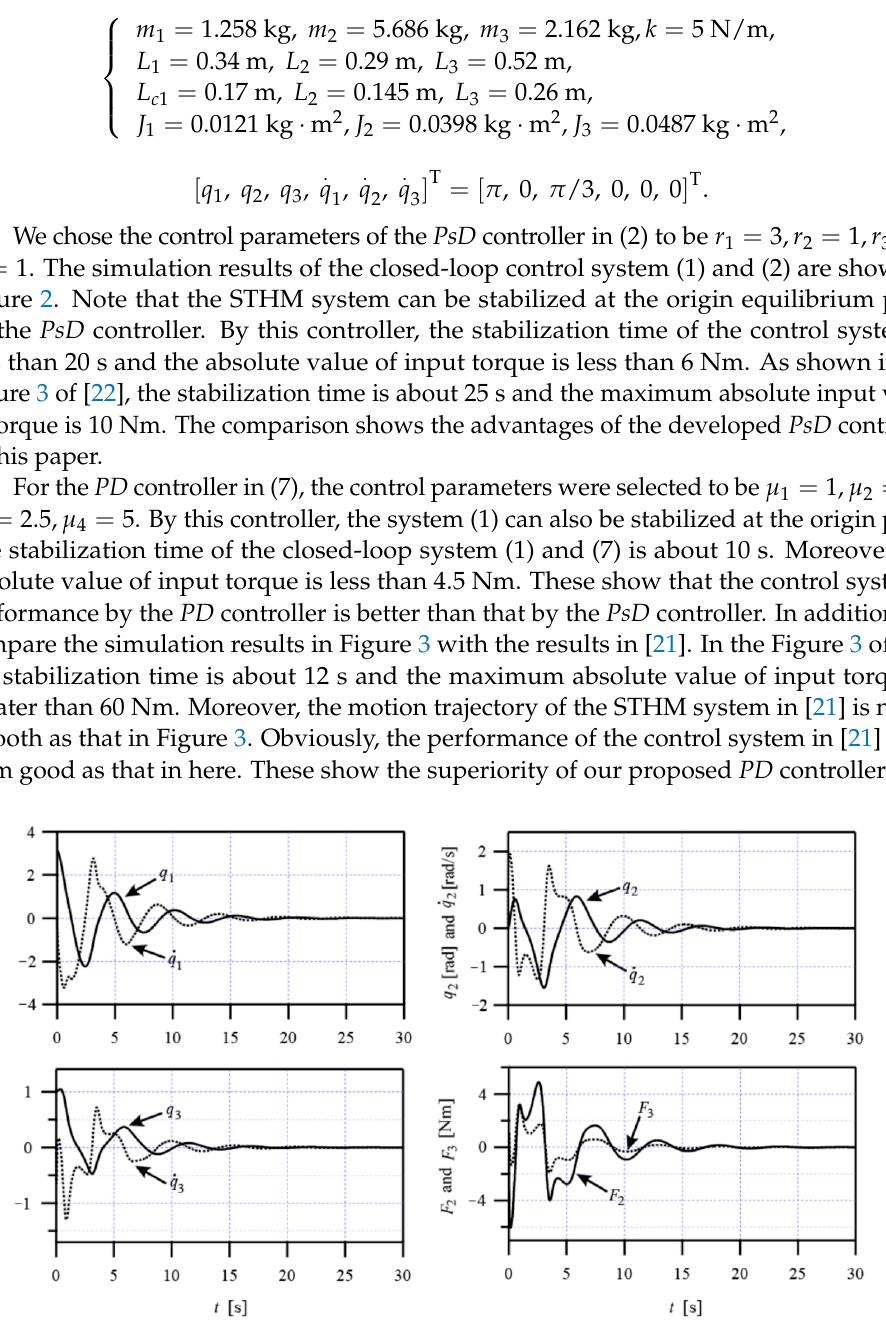
Figure 3. Simulation results for the control system (1) and (7). For the PD controller in (7), the control parameters were selected to be 1